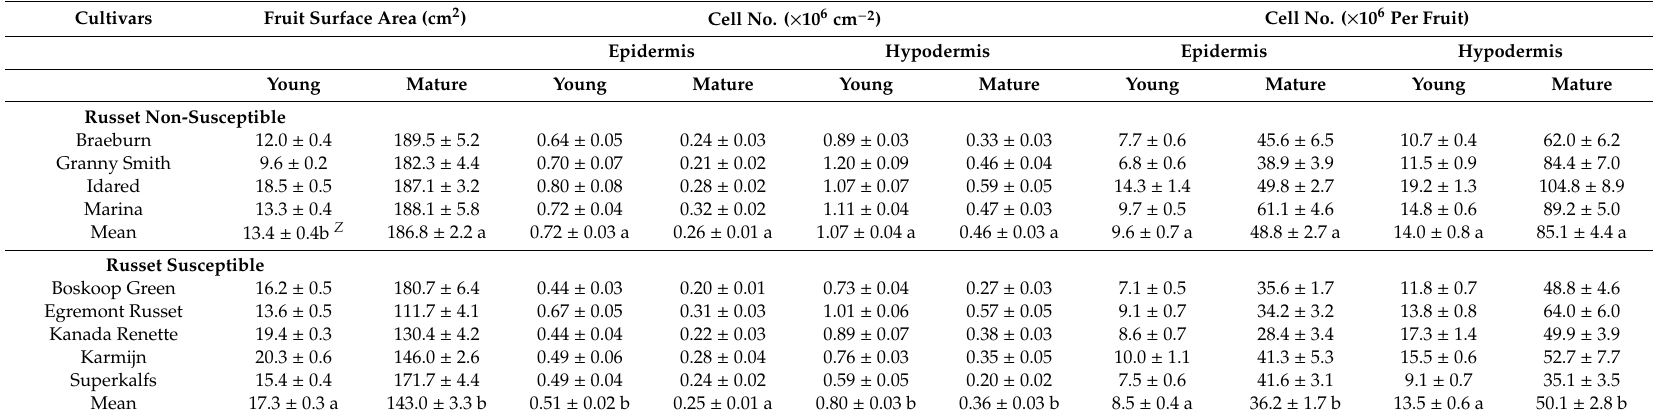
Table 1. Fruit surface area and epidermal and hypodermal cell number per fruit and per unit fruit surface area of young (28–35 days after full bloom) and mature fruit of selected russet non-susceptible and russet-susceptible apple cultivars. Results for ‘Idared’ and ‘Karmijn’ were taken from Figure 2. Data in the table represent means ± SE. The number of replicates was